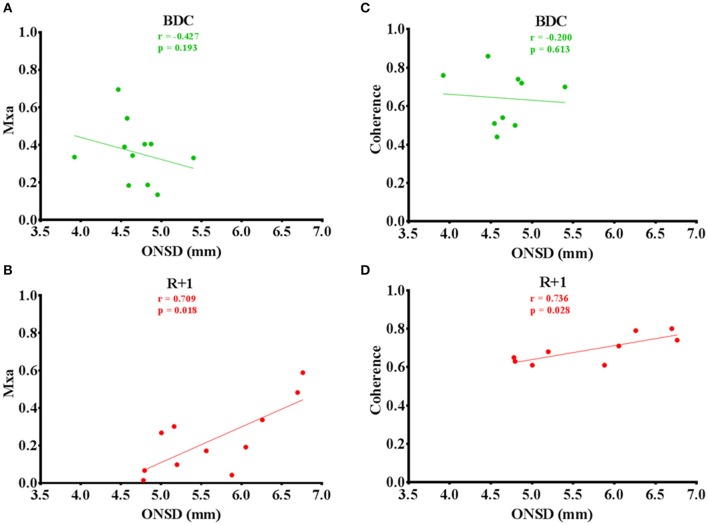
(A–D) Mxa and coherence values plotted versus ONSD before (green circles) and after (red circles) dry immersion with linear regression (solid lines).